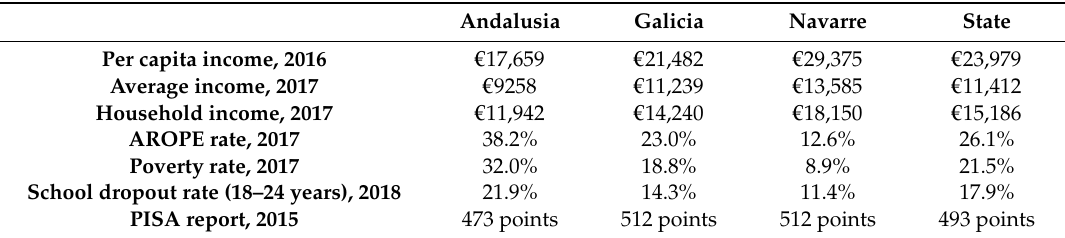
Table 2. Socioeconomic and educational vital statistics of the four administrations 1